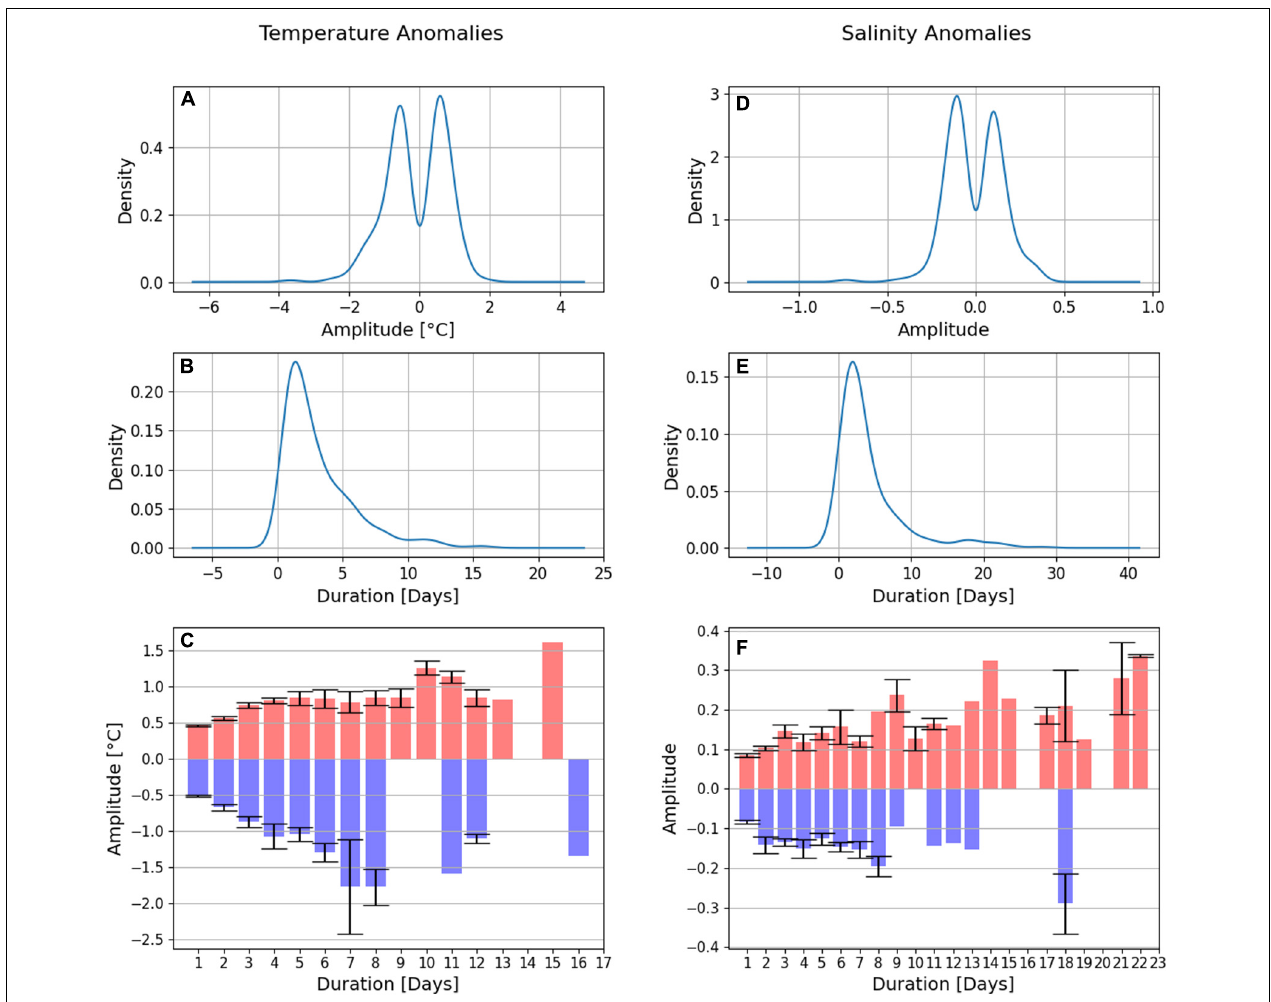
FIGURE 8 | Kernel density estimation of amplitudes (A,D) and durations (B,E) for anomalies of temperature and salinity, respectively. Averaged temperature (C) and salinity (F) amplitudes of positive (red) and negative (blue) anomalies grouped by their duration. Standard error bars are shown where anomalies of a specific duration occurred more than